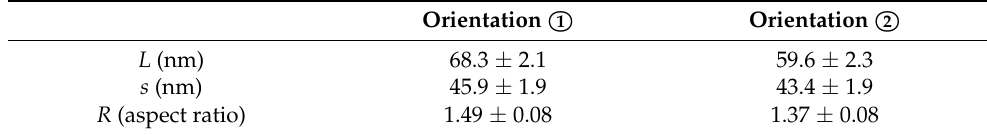
Table 5. Size and shape results obtained for the two populations oriented 1 (cid:13) and 2 (cid:13) .